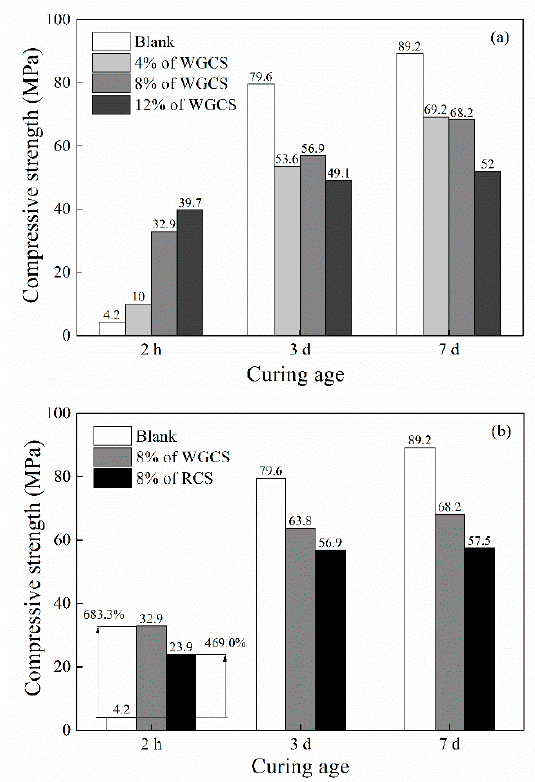
Figure 4. Compressive strength of CS–CSA pastes (maximum error was 5.4 MPa). ( a ) Blank and 4, 8, 12% of WGCS at 2 h, 3 d, 7 d; ( b ) Blank, 8% of RCS and 8% of WGCS at 2 h, 3 d, 7 d.